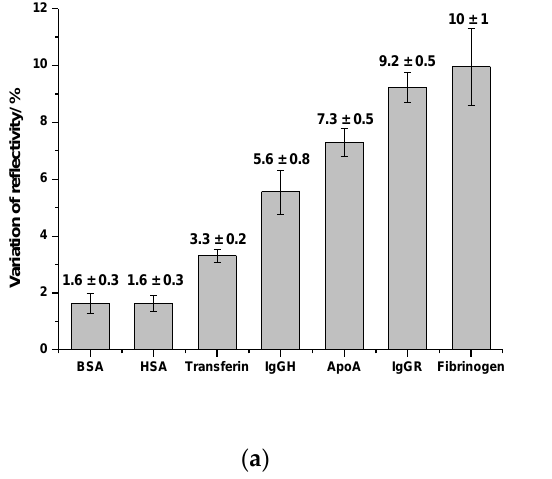
Figure 8. Average and standard deviation of the variation of reflectivity observed in the SPRi curves after the injection of gold NPs ( a ) and silver NPs ( b ) on the protein-functionalized biochip surface. In the assays performed with silver NPs, the highest average value of the variation of reflectivity was observed on IgGR spots (2.1 ± 0.2)%, followed by ApoA (1.7 ± 0.1)% and fibrinogen (1.1 ± 0.1)%. Different from what was observed with the gold NPs, the interac- tion of silver NPs did not show a high variation between the tested proteins. The interac- tion of silver NPs with the other proteins resulted in values of variation of reflectivity only slightly lower in the 0.7 – 0.9% range. In addition to the information regarding the composition of the NPs protein corona and the comparative evaluation of proteins adsorption on the NPs surface, the SPRi tech- nique can also be applied to quantitatively evaluate the affinity between them. The kinetic curves obtained in the assays with gold and silver NPs were used to calculate the dissoci- ation constant (k off ) after the interaction of NPs with proteins (see Supporting Information for a detailed description of the calculus). The values are depicted in Table 1. Table 1. Values of k off calculated by using the SPRi kinetics data of the interaction between AuNPs, AgNPs and proteins, and the values of K off reported in the indicated references. Protein